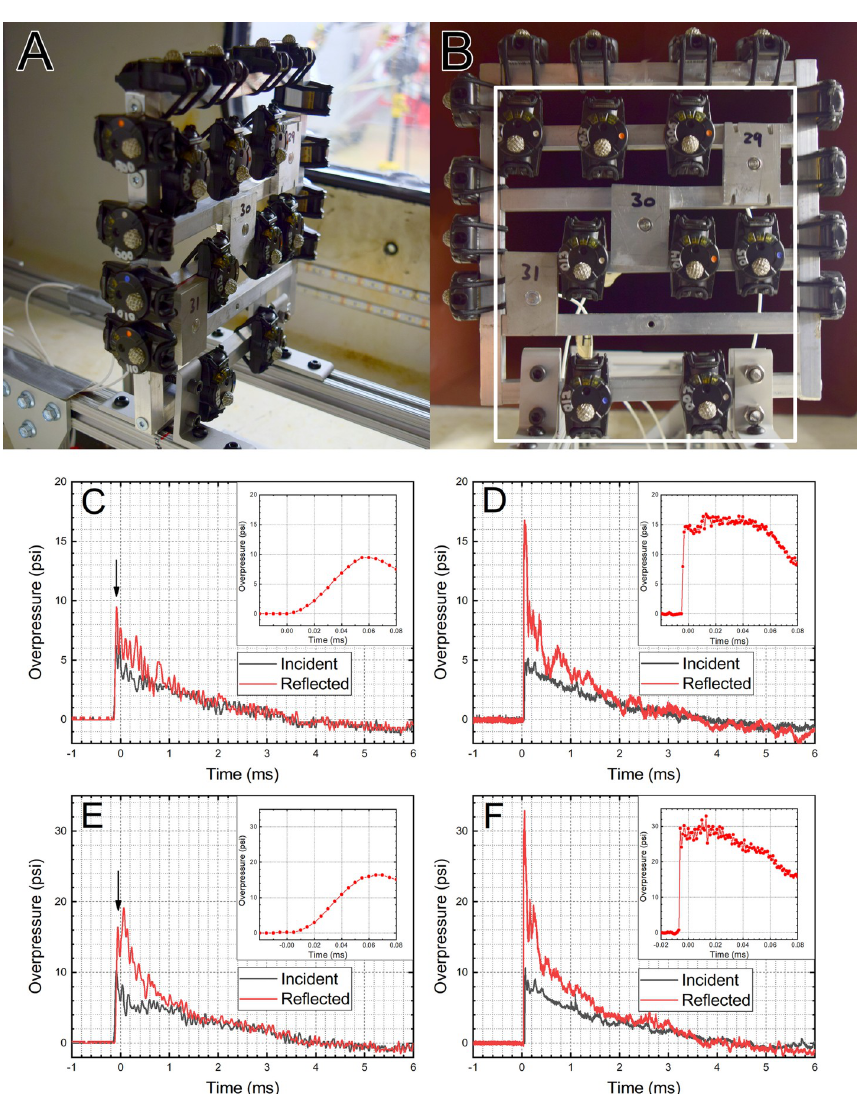
Fig 1. The experimental setup for the shock tube experiments. The 12 B3 sensors mounted around the perimeter are in the incident pressure orientation (A), while 8 B3 and 3 PCB sensors inside of the white rectangle are in the reflected pressure orientation and reflected pressure measurement configuration (B). Two nominal shock wave intensities were used: 5 psi (C, D) and 10 psi (D, F). Representative pressure waveforms for B3 (C, E) and PCB (E, F) sensors are presented. Insets: the reflected overpressure reported by B3 and PCB sensors in the initial 0.08 milliseconds, reveals striking differences in the dynamic response.